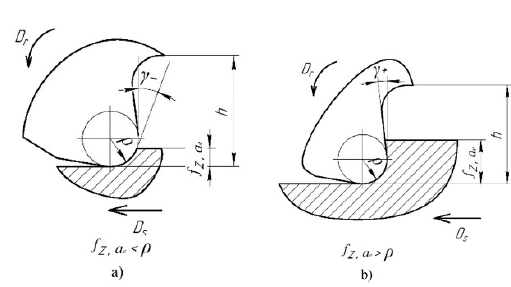
Fig. 1. Cutting edge rounding radius related to the cutting data parameters: a) conditions for inefficient chip formation, b) conditions for effective chip